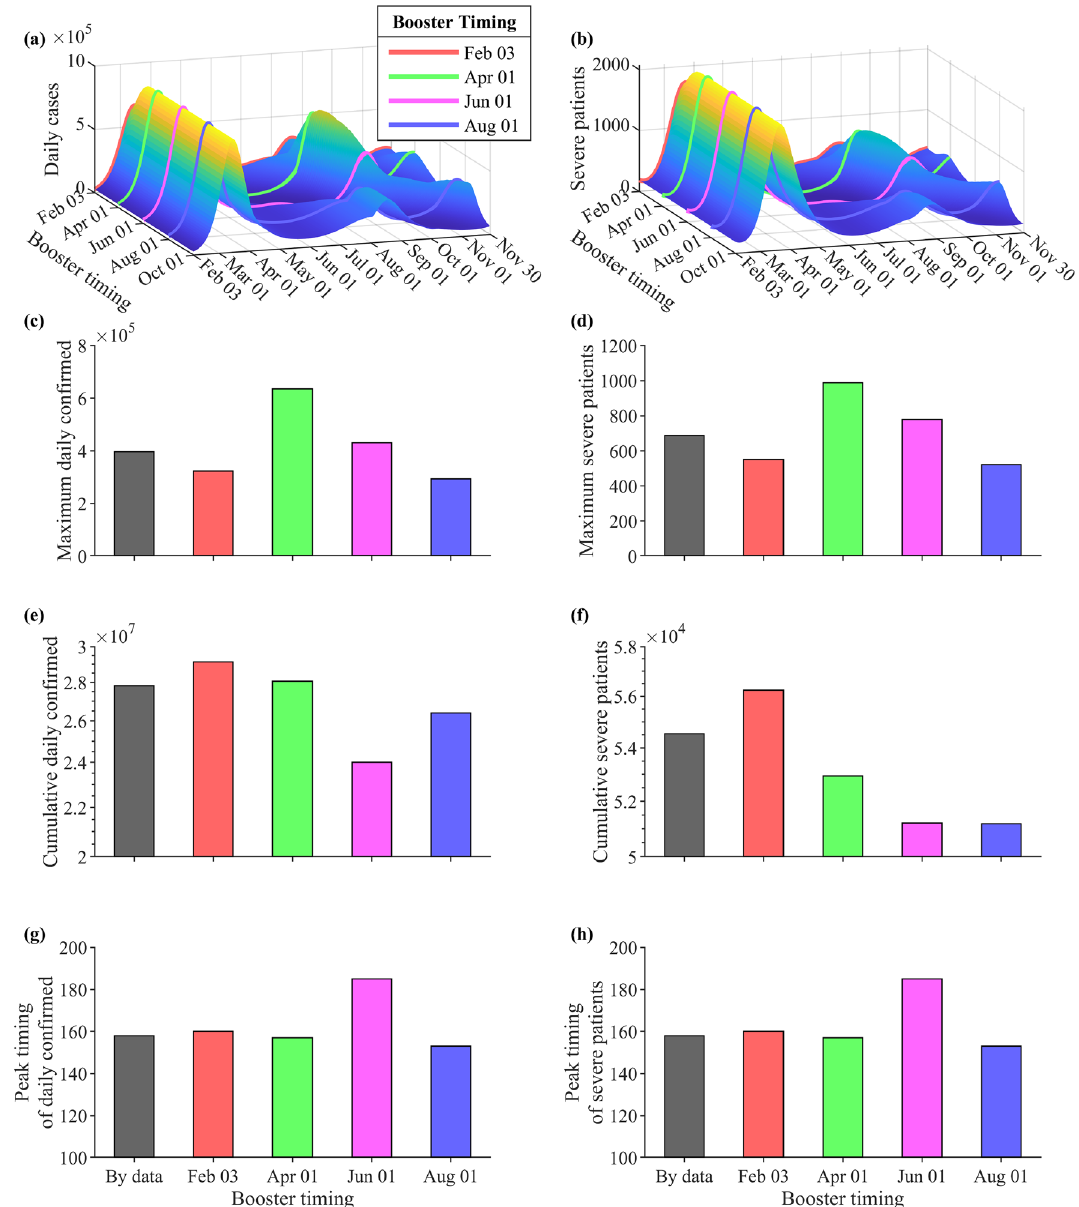
Figure 5. Simulation results when the additional 14 million vaccines were given at different times in 2022. The red, green, magenta, or blue curves and bars correspond to the results when the booster shots were given for a month starting on February 3, April 1, June 1, or August 1, 2022, respectively. Panels ( a,b ) show the daily cases and severe patients for each scenario. The black bars represent the simulation results using the vaccination data in Korea. Panels ( c–h ) illustrate the peak, cumulative, and timing of the second Omicron wave,